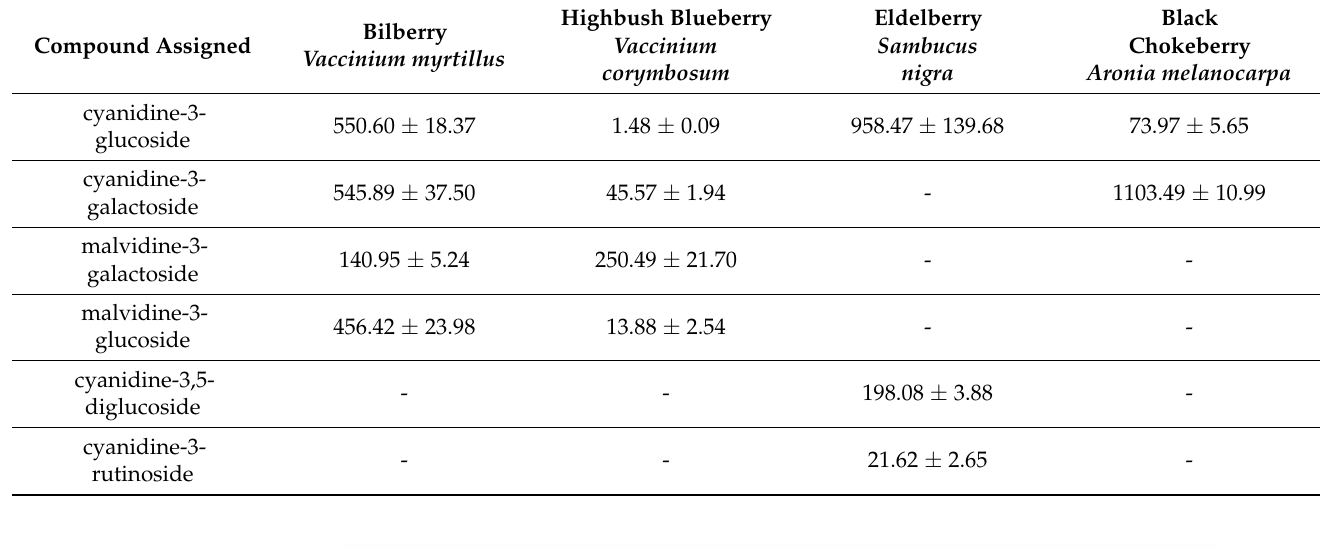
Table 4. Quantitative anthocyanin content of acetone extracts by LC-MS-IT-TOF analyses [ppm]. (-: absence).